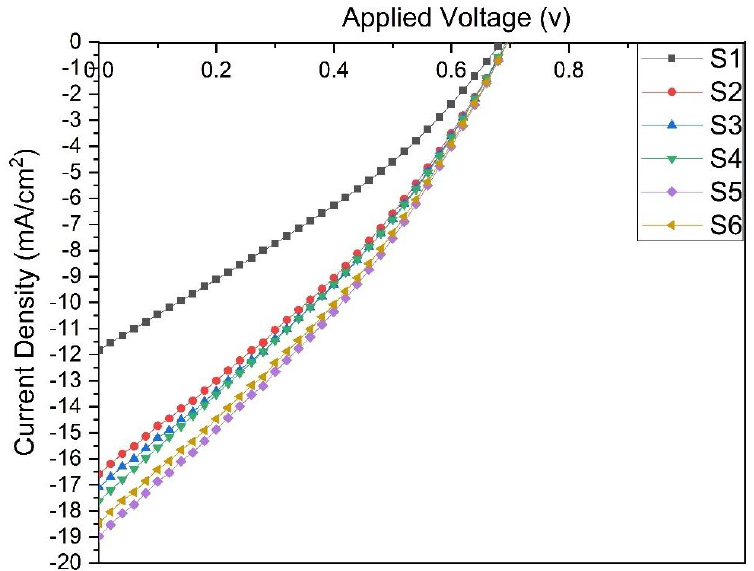
Figure 6. J–V curves of OSCs with and without Au@Ag-(8%, 10%, 12%, 14%, and 16%) NPs.